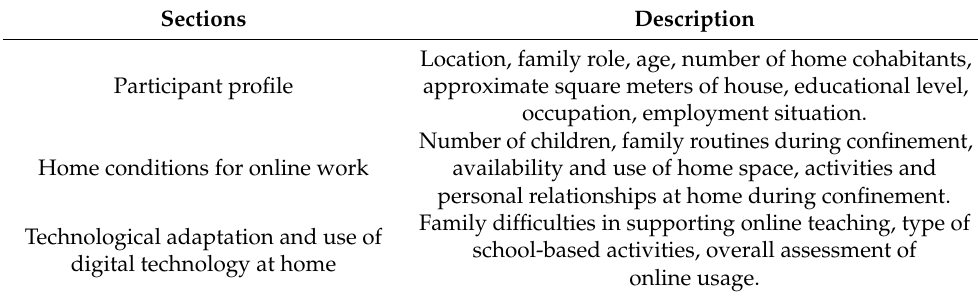
Table 2. School at Home (SH) survey content sections.